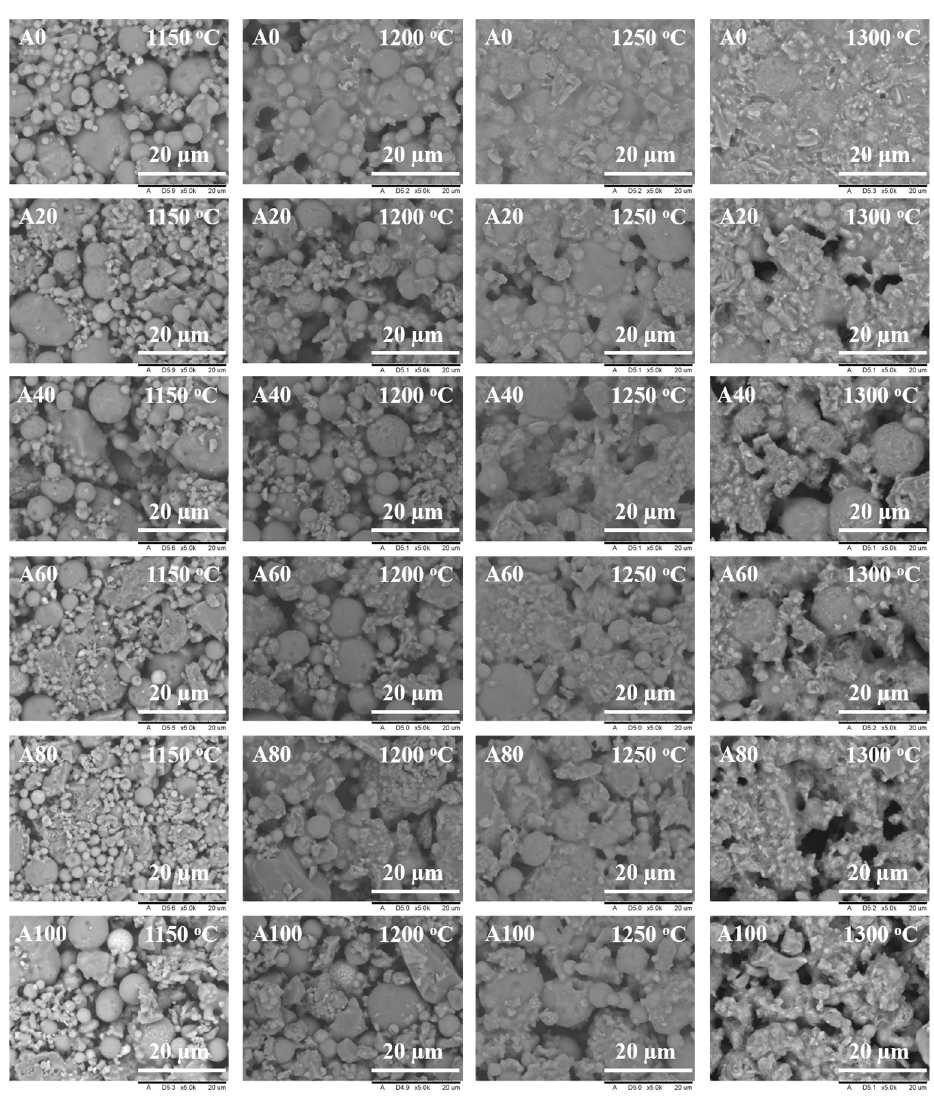
Figure 3. Microstructures of fly ash supports obtained by sintering at different temperatures with different bauxite contents. different bauxite